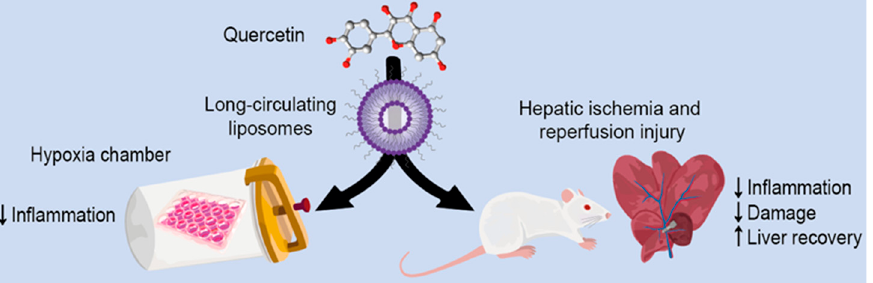
Figure 1. In vitro and in vivo evaluation of the anti-inflammatory potential of quercetin liposomes. Stable quercetin liposomes (Q-Lip) were developed and characterized, presenting a mean diameter under 0.13 µ m with a low polydispersity index, zeta potential values around zero (mV) at pH 6.0 and a quercetin to lipid ratio of 31 ± 3 µ g/ µ mol. An in vitro